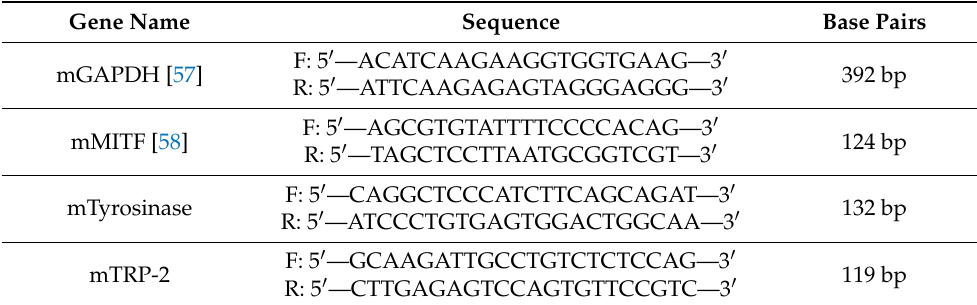
Table 1. Primer sequences for